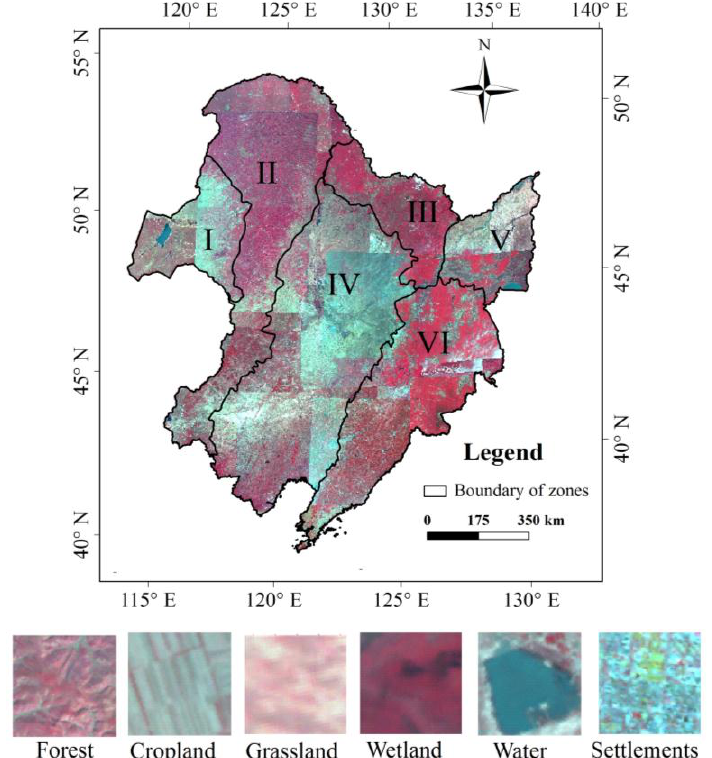
Figure 3. False color images, typical land cover types and zones based on climate and vegetation for the forest classification of Northeast China (I: Hulun Buir region; II: Daxing’an Mountains; III: Xiaoxing’an Mountains; IV: Songliao Plain; V: Sanjiang Plain; VI: Changbai Mountains).